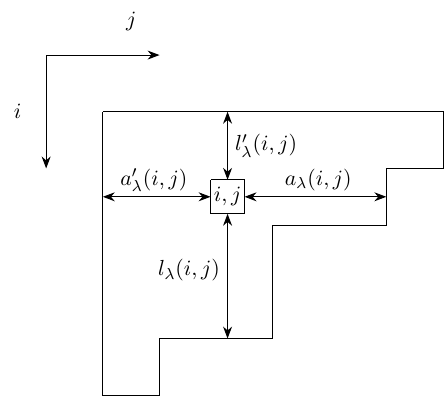
Figure 9 . Arm and leg (co)length of a box ( i, j ) in a Young